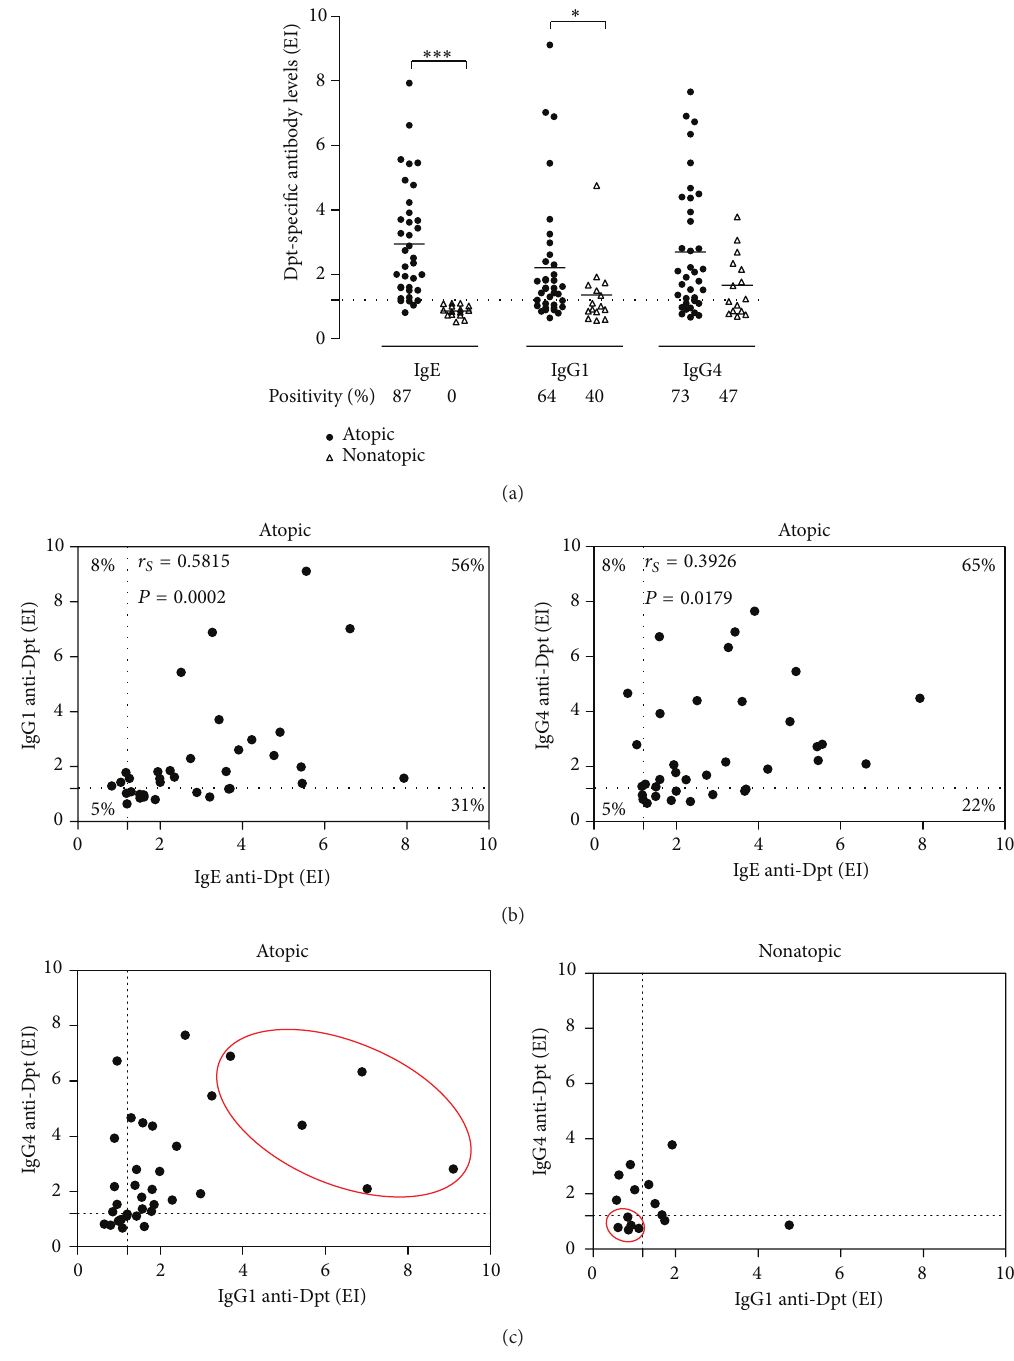
Figure 1: (a) Levels of IgE, IgG1, and IgG4 antibodies to Dermatophagoides pteronyssinus (Dpt) allergen extract in serum samples from atopic and nonatopic patients. Data are expressed in ELISA index (EI), and mean is indicated by horizontal bars. The dashed line indicates the cutoff of the reaction (EI > 1.2 ). Percentages of positive samples are also indicated. Statistically significant differences were determined by the Mann-Whitney test ( ∗ 𝑃 < 0.05 ; ∗∗∗ 𝑃 < 0.0001 ). (b) Correlation between levels of Dpt-specific IgE versus IgG1 and IgE versus IgG4 anti-Dpt in serum samples from atopic patients. Percentages of double positive, double negative, or single positive for each antibody class are indicated in the correspondent corners. Spearman’s correlation coefficient and statistical significance are also indicated. (c) Comparison between levels of IgG1 and IgG4 anti-Dpt in serum samples from atopic and non-atopic patients. Five serum samples (red ellipses) of each patient group were selected to constitute the specific (atopic) and nonspecific (nonatopic) total IgG pools. The dashed lines indicate the cutoff of the reaction (EI > 1.2